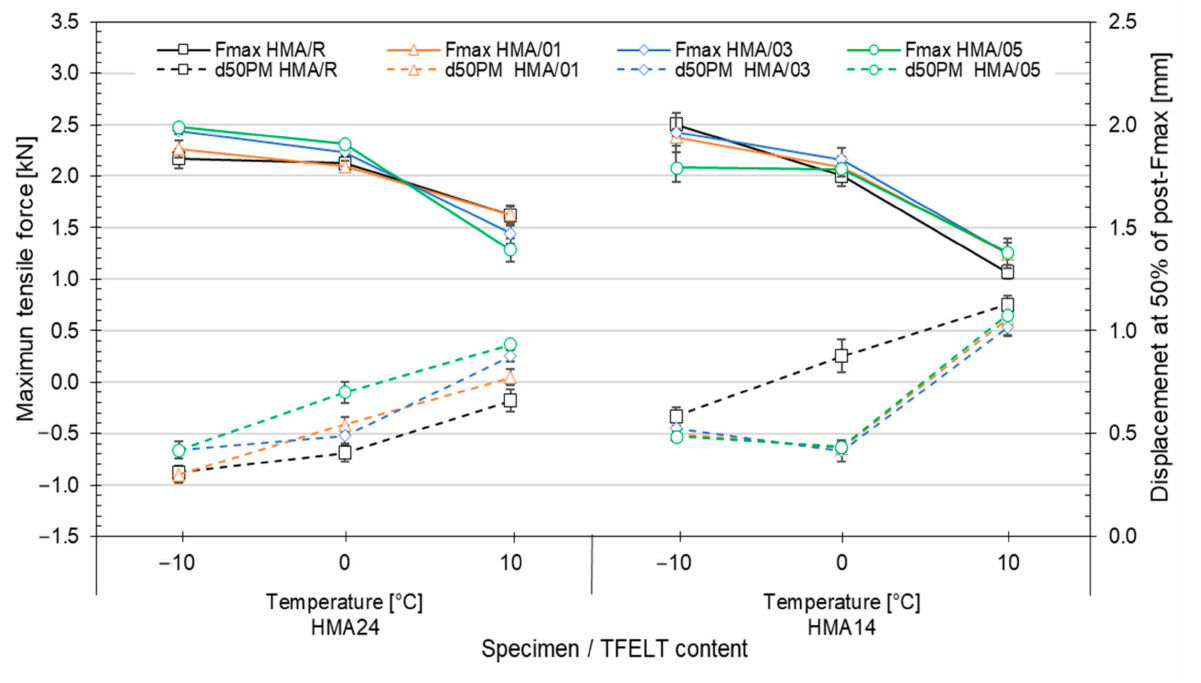
Figure 11. Fenix test results at − 10 ◦ C, 0 ◦ C and 10 ◦